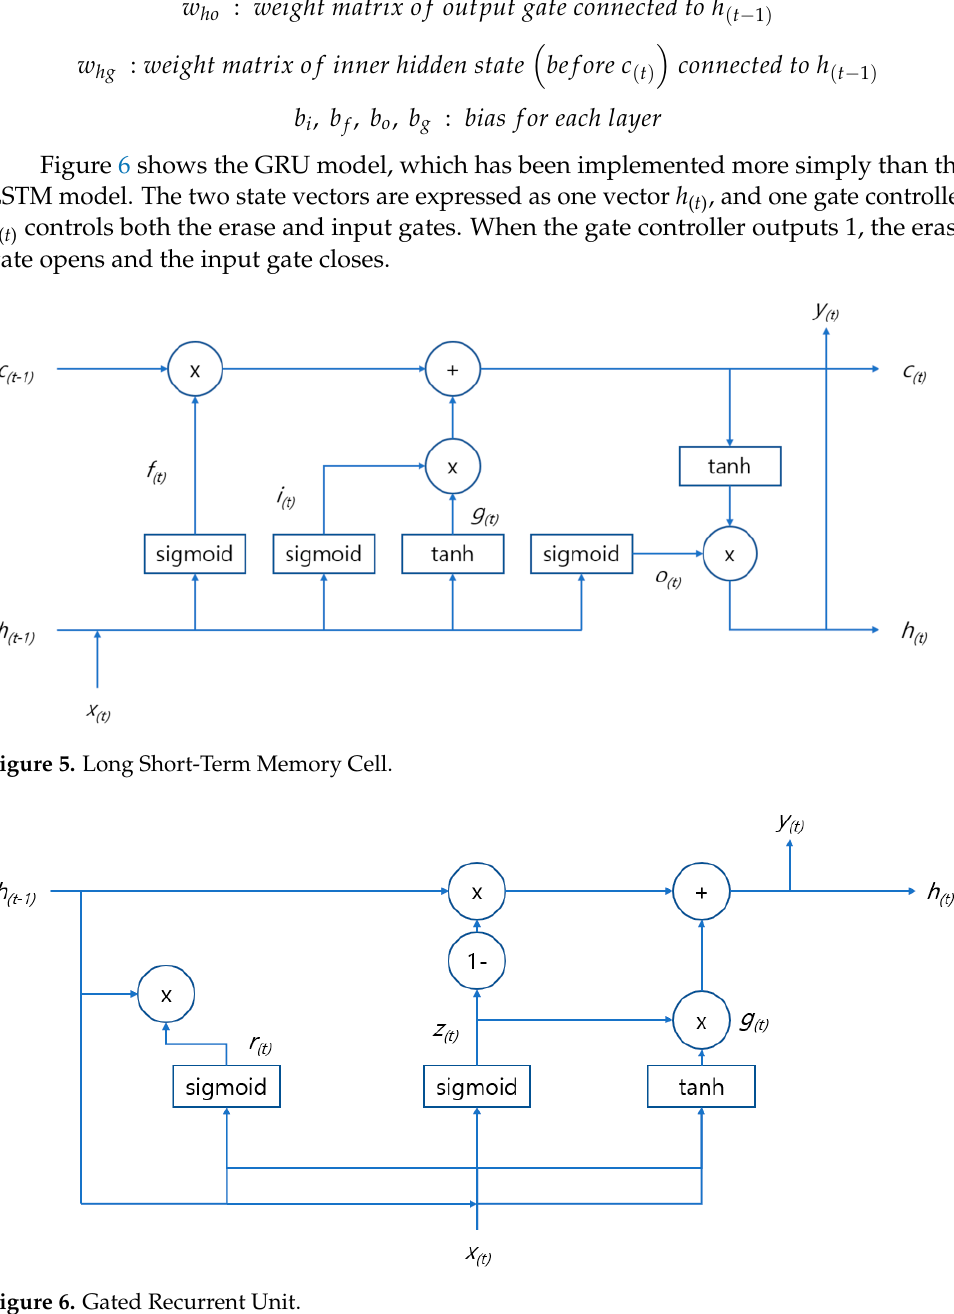
Figure 6. Gated Recurrent Unit.